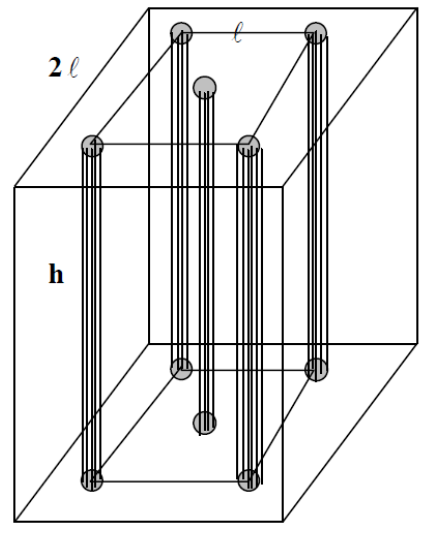
Figure 5. Square prismatic RVE.